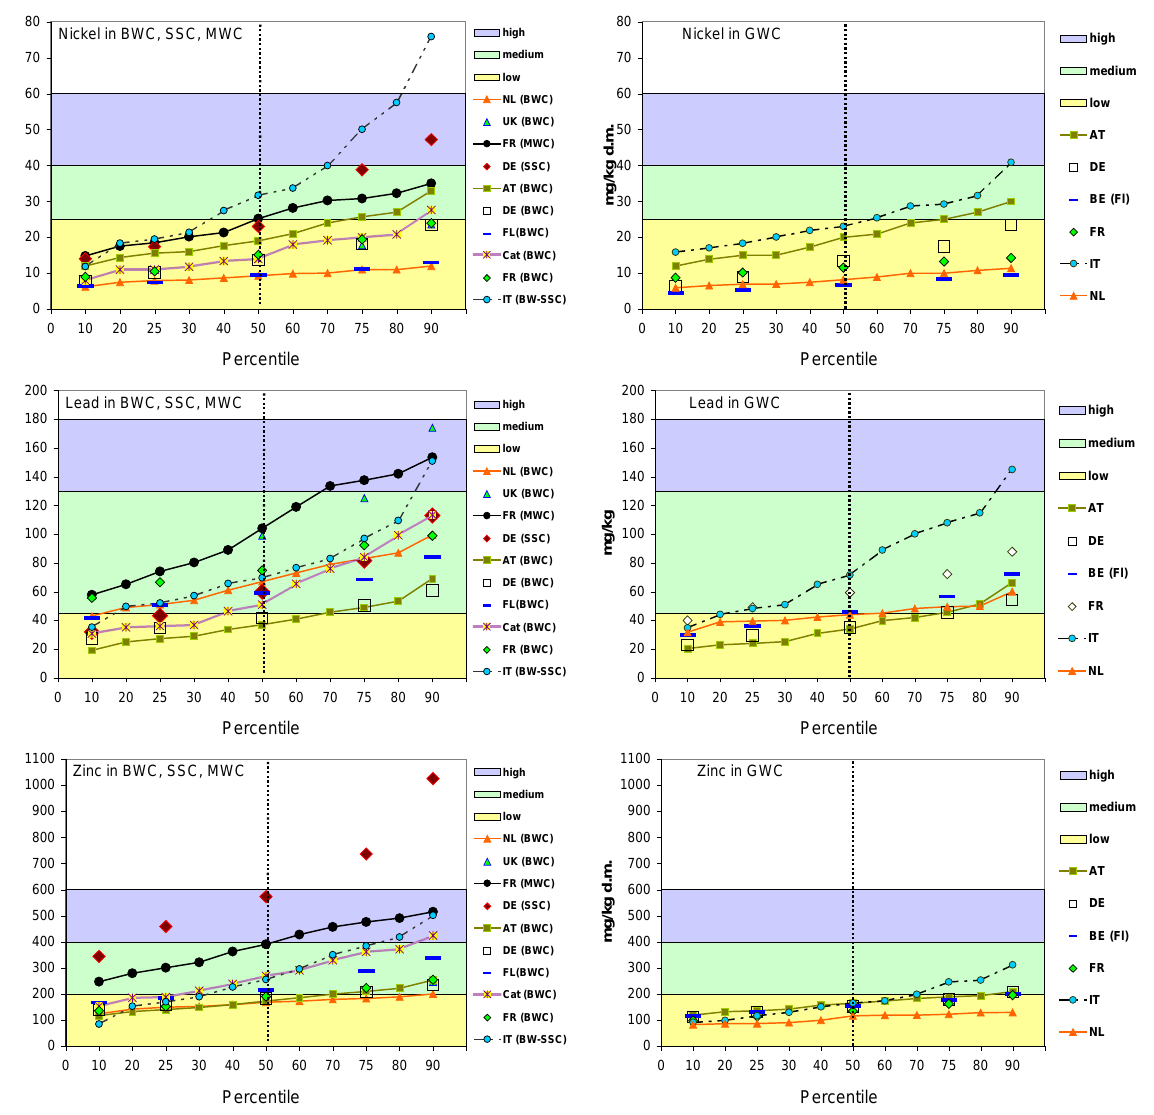
Figure 5: Distribution of heavy metal concentrations in BWC, SSC, MWC (left) and GWC (right) from several national investigations and data sets in relation to the assumed three levels of heavy metal